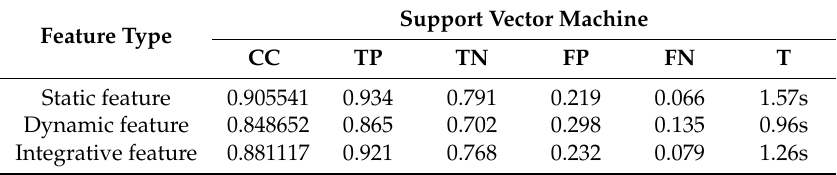
Table 6. The results of the AdaBoost algorithm. CC (Correctly Classified rate, CC), TP (True